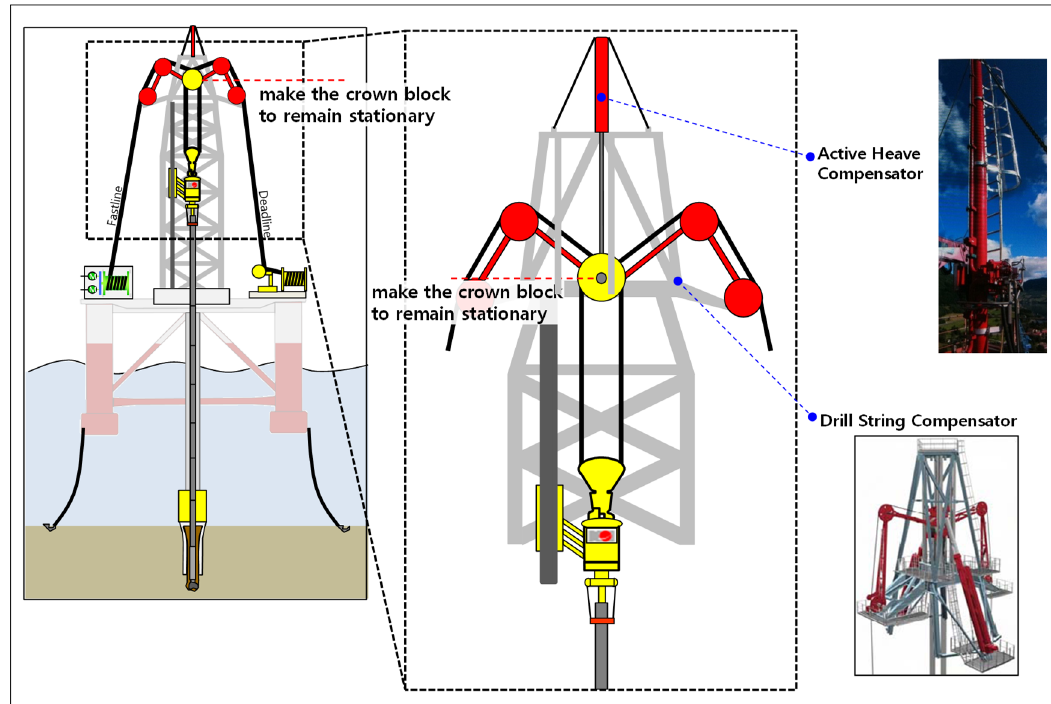
Figure 4. Components of a heave compensation system.